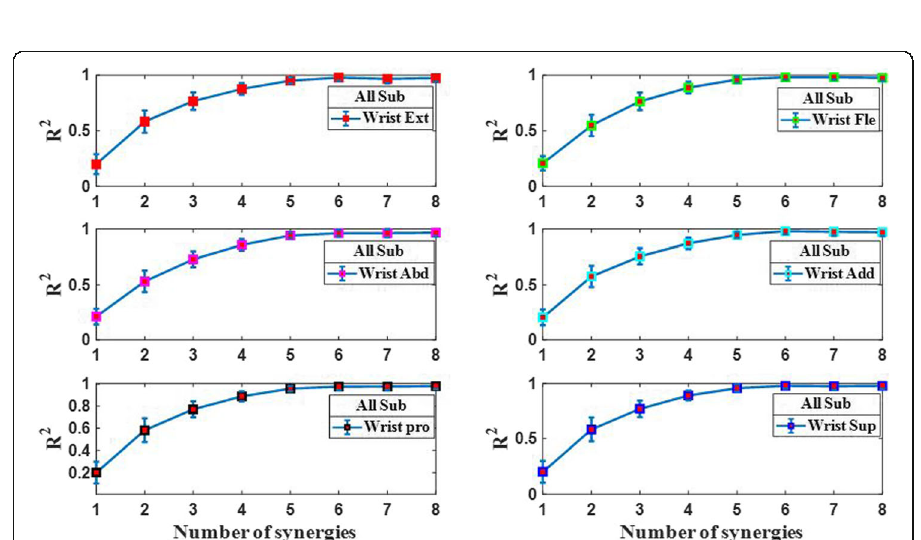
Fig. 4 R 2 index variation vs. synergy vectors number plotted for each wrist